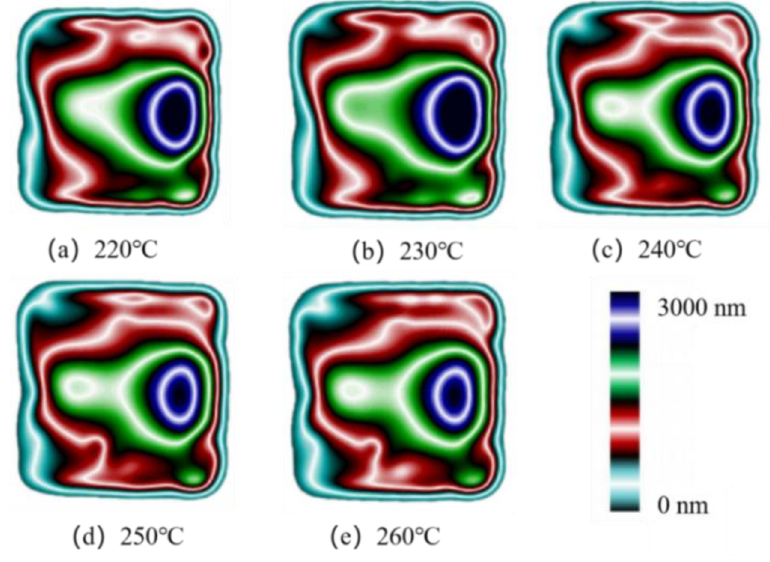
Figure 18. Birefringence distributions at different melt temperatures.